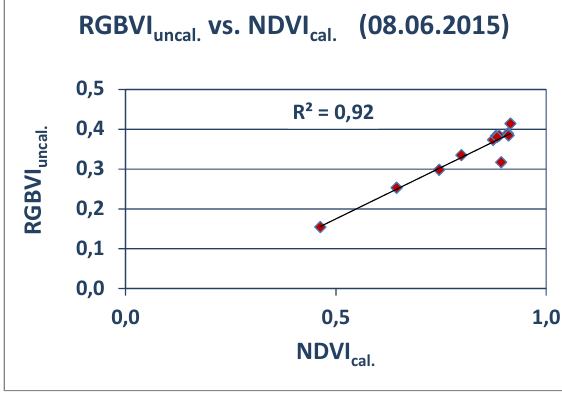
Figure 7. Evaluation of the RGBVI uncal. vs. NDVI cal. for the N experiment for June 8 th , 2015